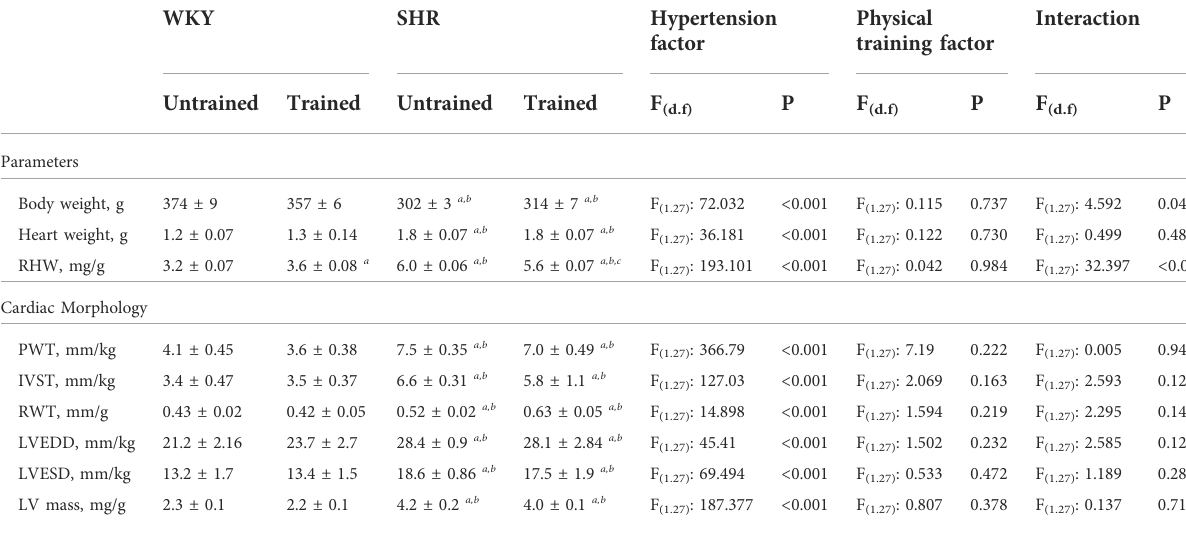
Physical Interaction factor training factor